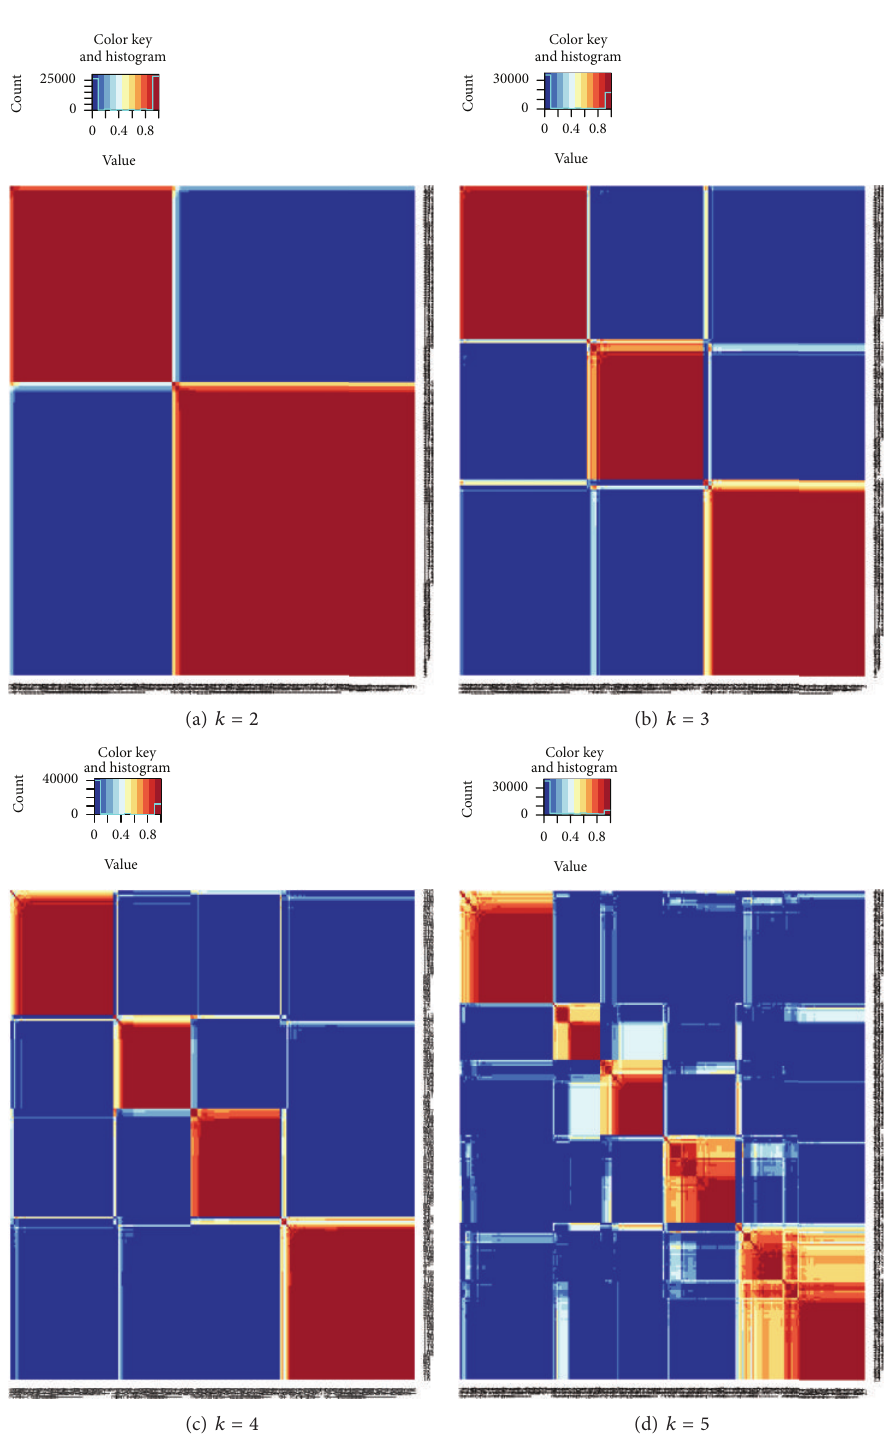
Figure 1: Consensus clustering results of 7395 genes for rank 𝑘 = 2, ...,5